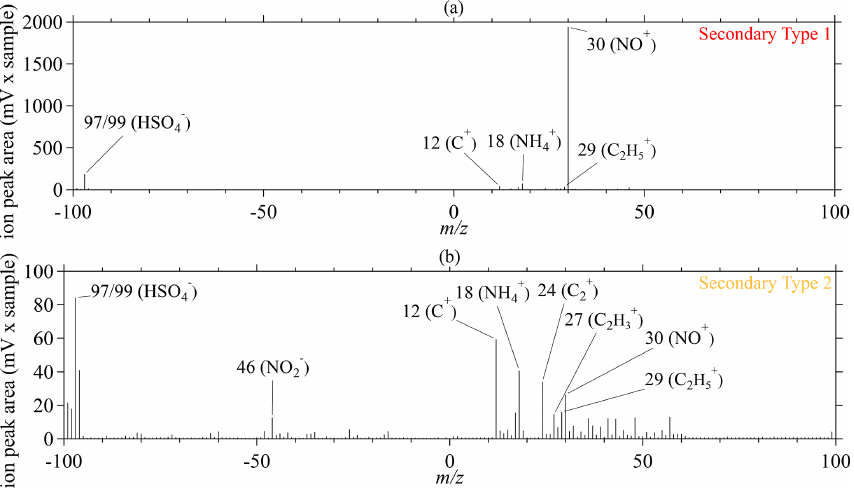
Figure 7. Bipolar mean spectra of the ERICA-LAMS particle types: (a) Secondary Type 1 (averaged over 33420 particles), (b) Secondary Type 2 (averaged over 6219